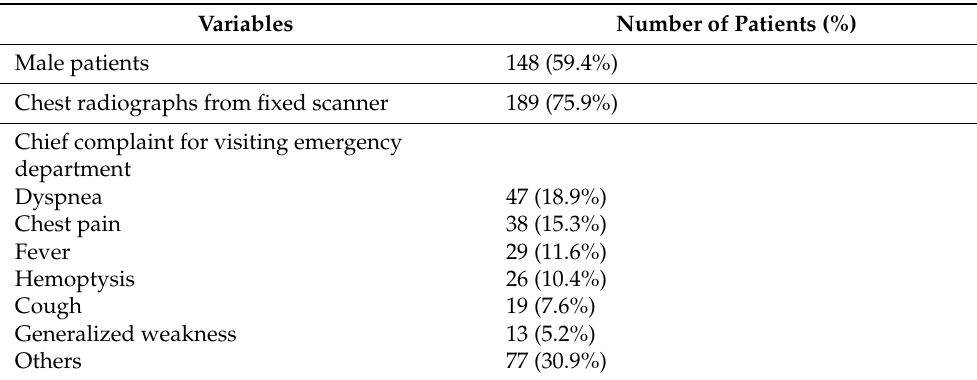
Table 1. Demographic and clinical characteristics of the patients included in the study. Variables Number of Patients